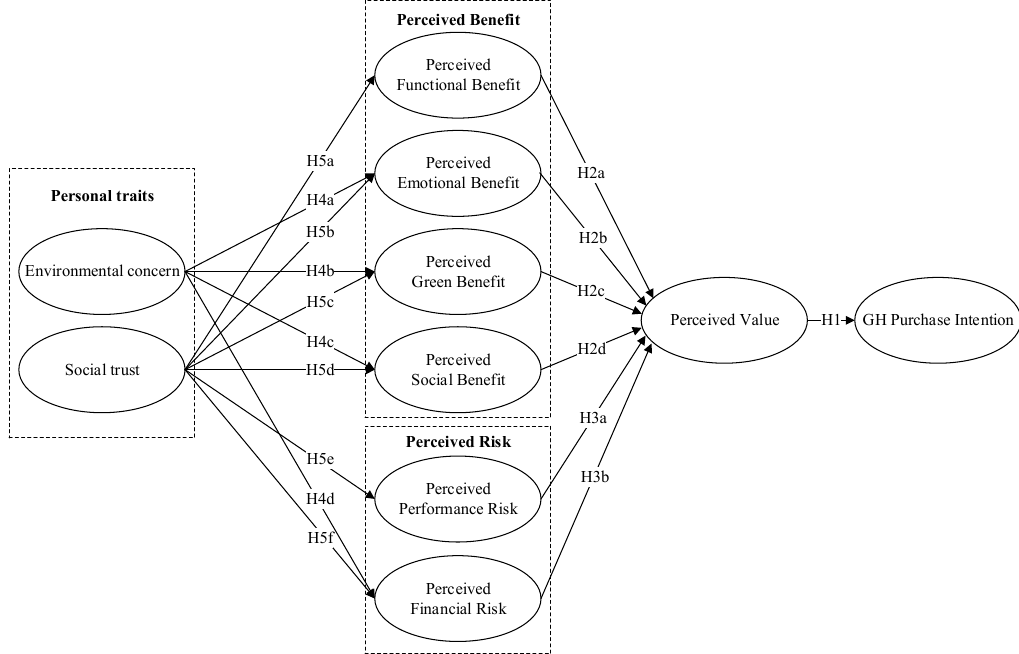
Figure 1. Research model of green house (GH) purchase